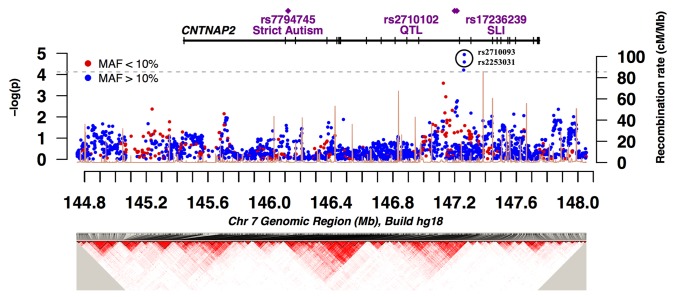
A plot of -log10
p across CNTNAP2 from family-based association test (TDT) results on 509 merged multiplex and simplex families.The bottom panel shows a plot of all pairwise correlations (linkage disequilibrium, D’) between 2148 SNPs in this genomic interval.